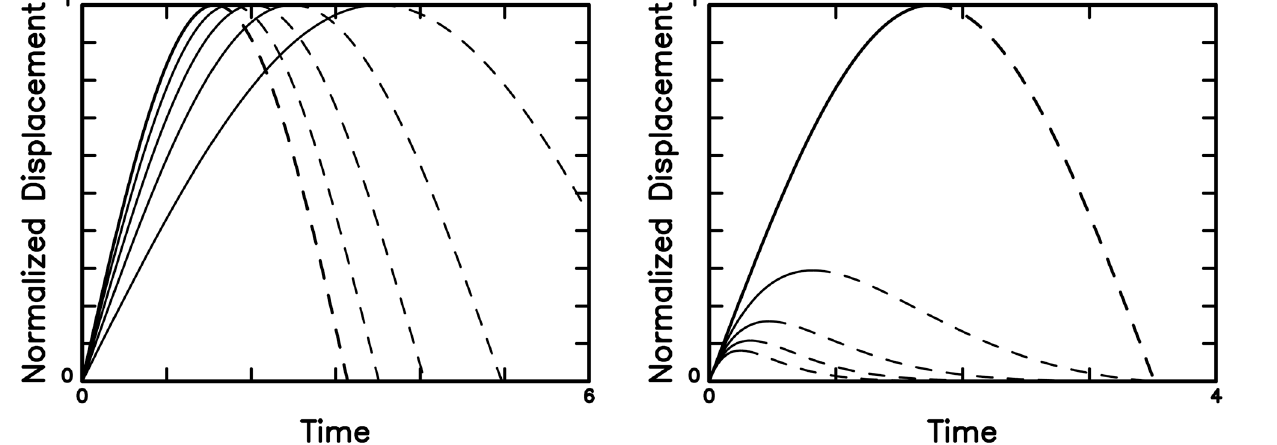
Figure 5. The slip of the slider for five values of c , i.e., 0, 2, 4, 6, 8 N/m (from left to right), when K = 10 N/m, m = 10 kg, and h = 0.